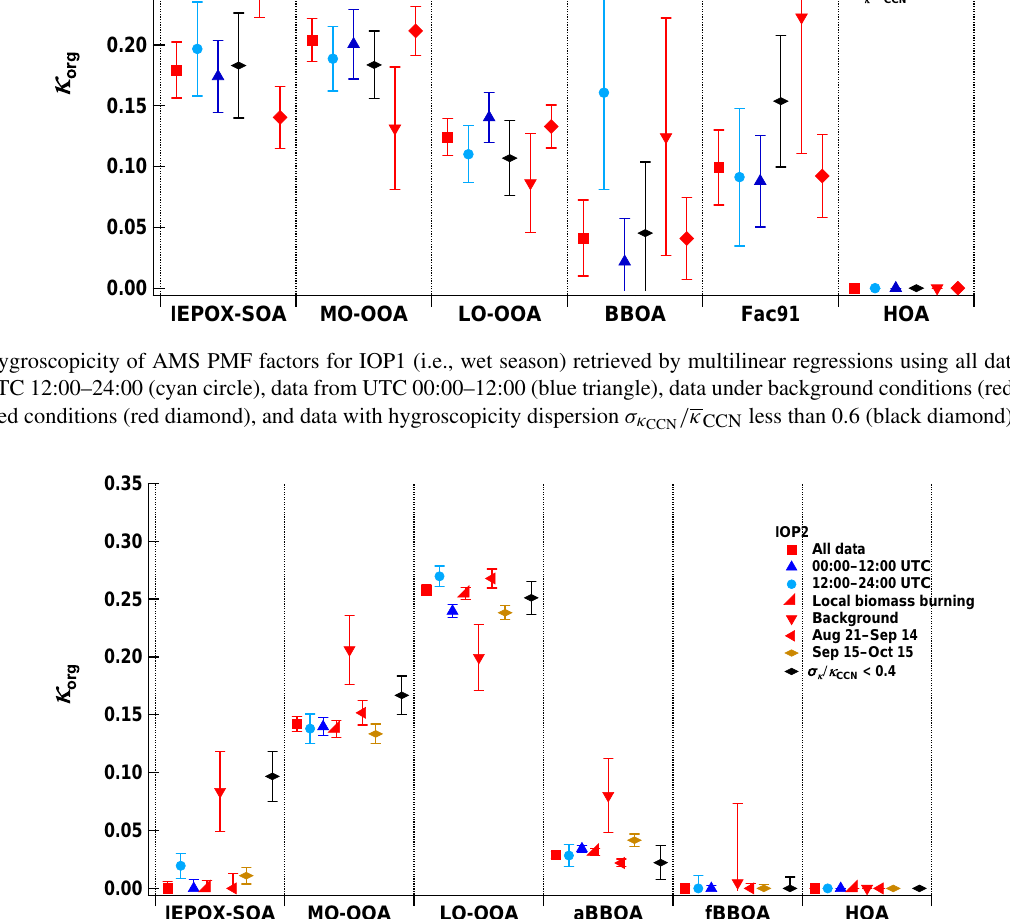
Figure 10. Hygroscopicity of PMF factors for IOP2 (i.e., dry season) retrieved by multilinear regressions using all data (red square), data from UTC 12:00–24:00 (cyan circle), data from UTC 00:00–12:00 (blue triangle), data with strong influence from local biomass burning (red right triangle), data under background conditions (red upside-down triangle), data from 21 August to 14 September 2014 only (red left-pointing triangle), data from 15 September to 15 October only (brown diamond), and data with a dispersion (σ κ